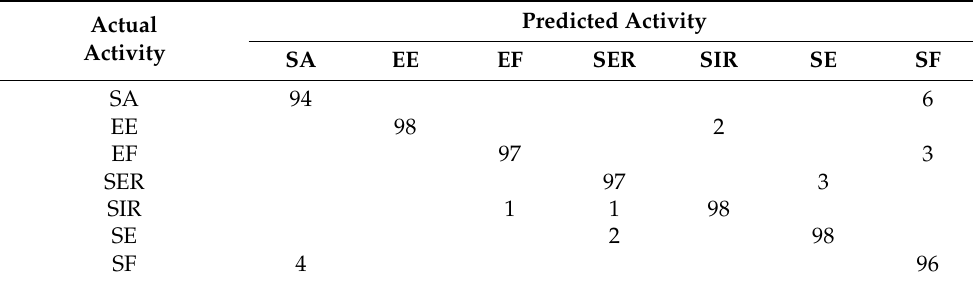
Table 5. Confusion matrix for RF classifier (in %). Cells with value 0 are left